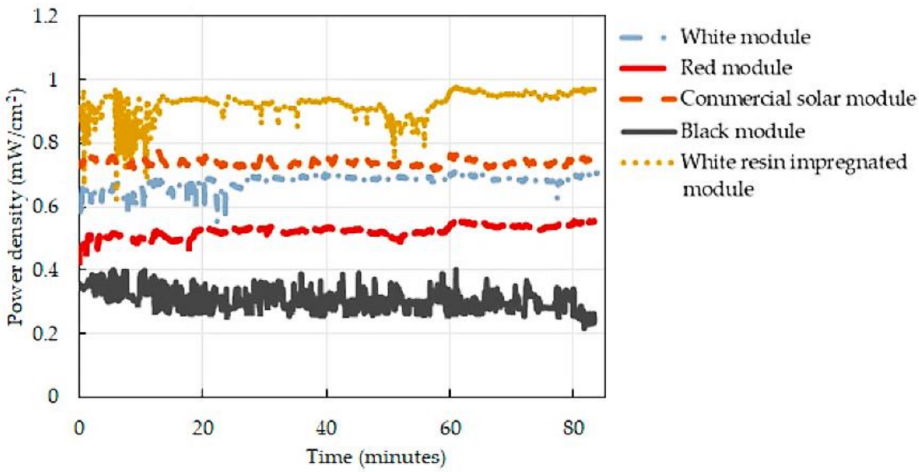
Figure 14. Power densities of five solar modules (four solar harvesting textiles and one flexible commercial solar cell) monitored for 85 min